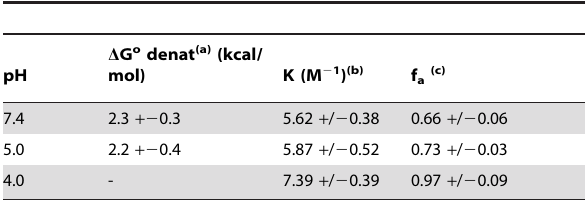
Table 1. Stability and solvent exposure of Trp residues of apoA-I at different pHs.